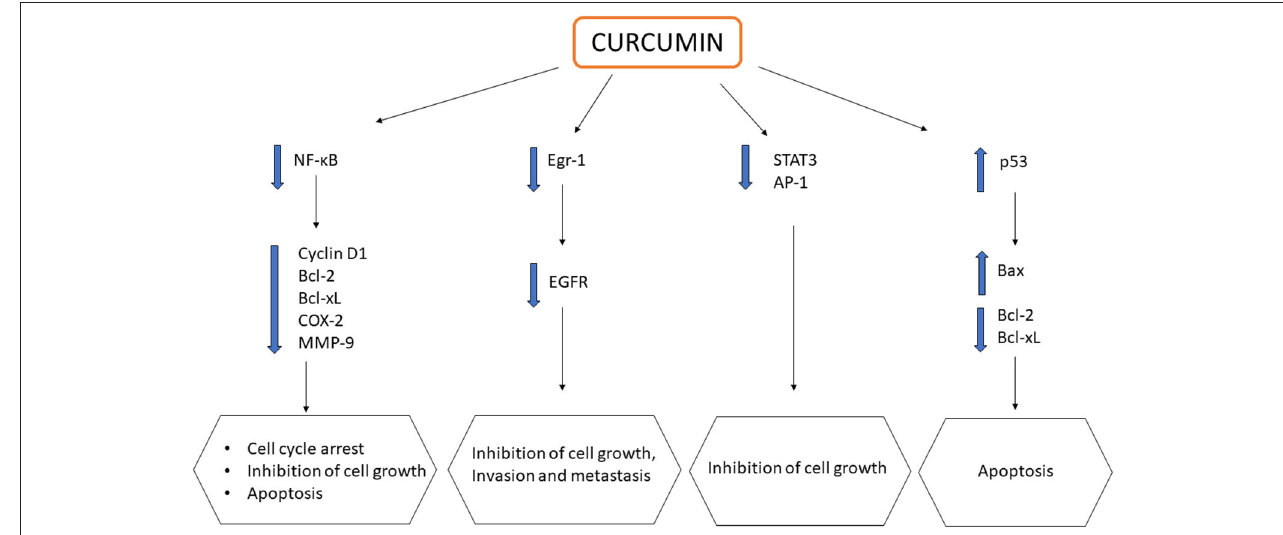
FIGURE 2 | Schematic representation showing impact of curcumin on multiple signaling pathways in cancers.